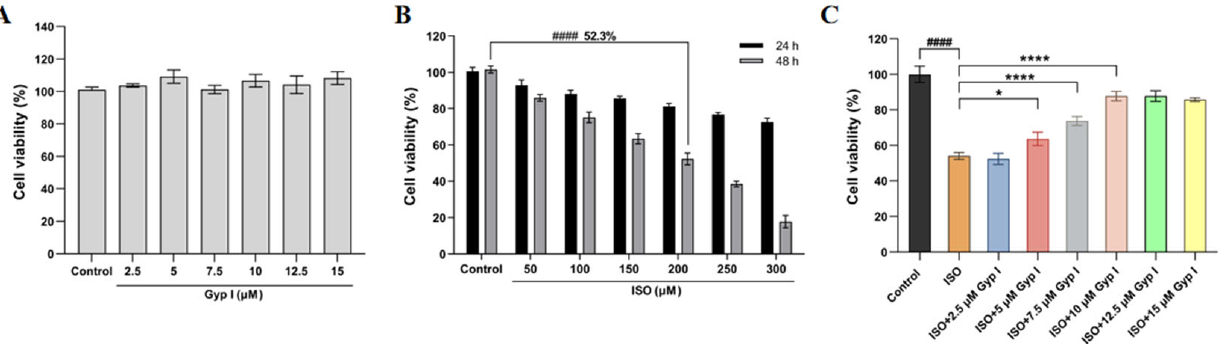
Figure 1. MTT assay to detect the survival rate of H9c2 cardiomyocytes: ( A ) Effect of Gyp I (2.5–15 μ M) on the viability of H9c2 cells at 48 h. ( B ) Effects of ISO (50–300 μ M) on H9c2 cell viability at 24 and 48 h. ( C ) Effects of Gyp I (5–15 μ M) on the viability of H9c2 cardiomyocytes induced by ISO (200 μ M). Results are presented as mean ± SD of three independent experiments using one ‐ way ANOVA followed by Tukey’s multiple ‐ comparison test (####: p < 0.0001 compared with Control group; *: p < 0.05, ****: p < 0.0001 compared with ISO group).